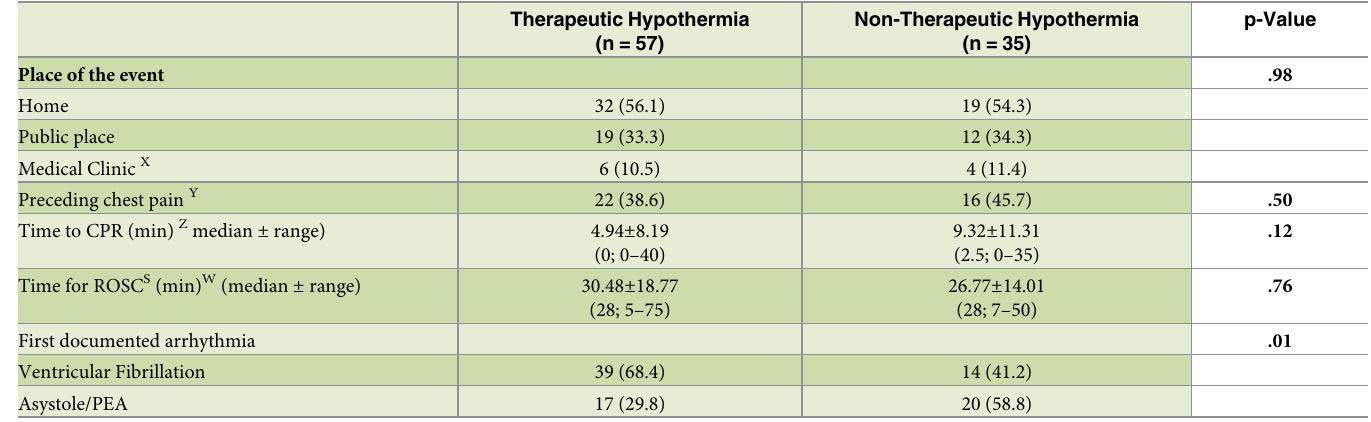
Table 1. Preliminary admission data